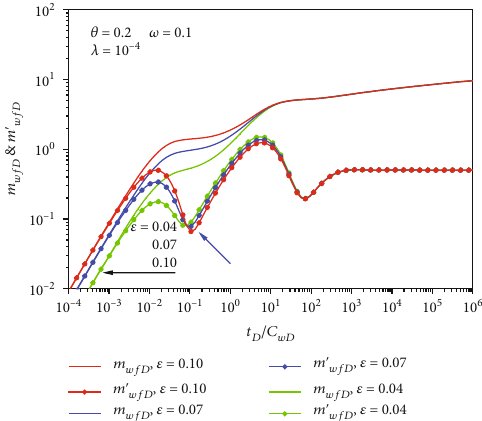
Figure 10: The in fl uence of cave volume